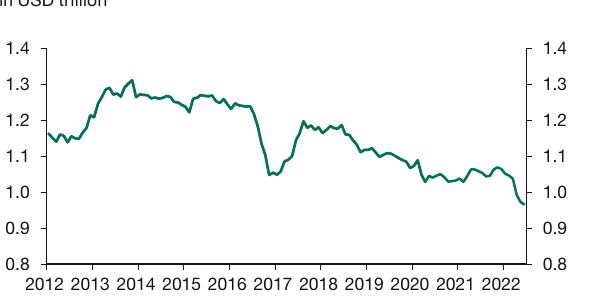
China’s holding of US